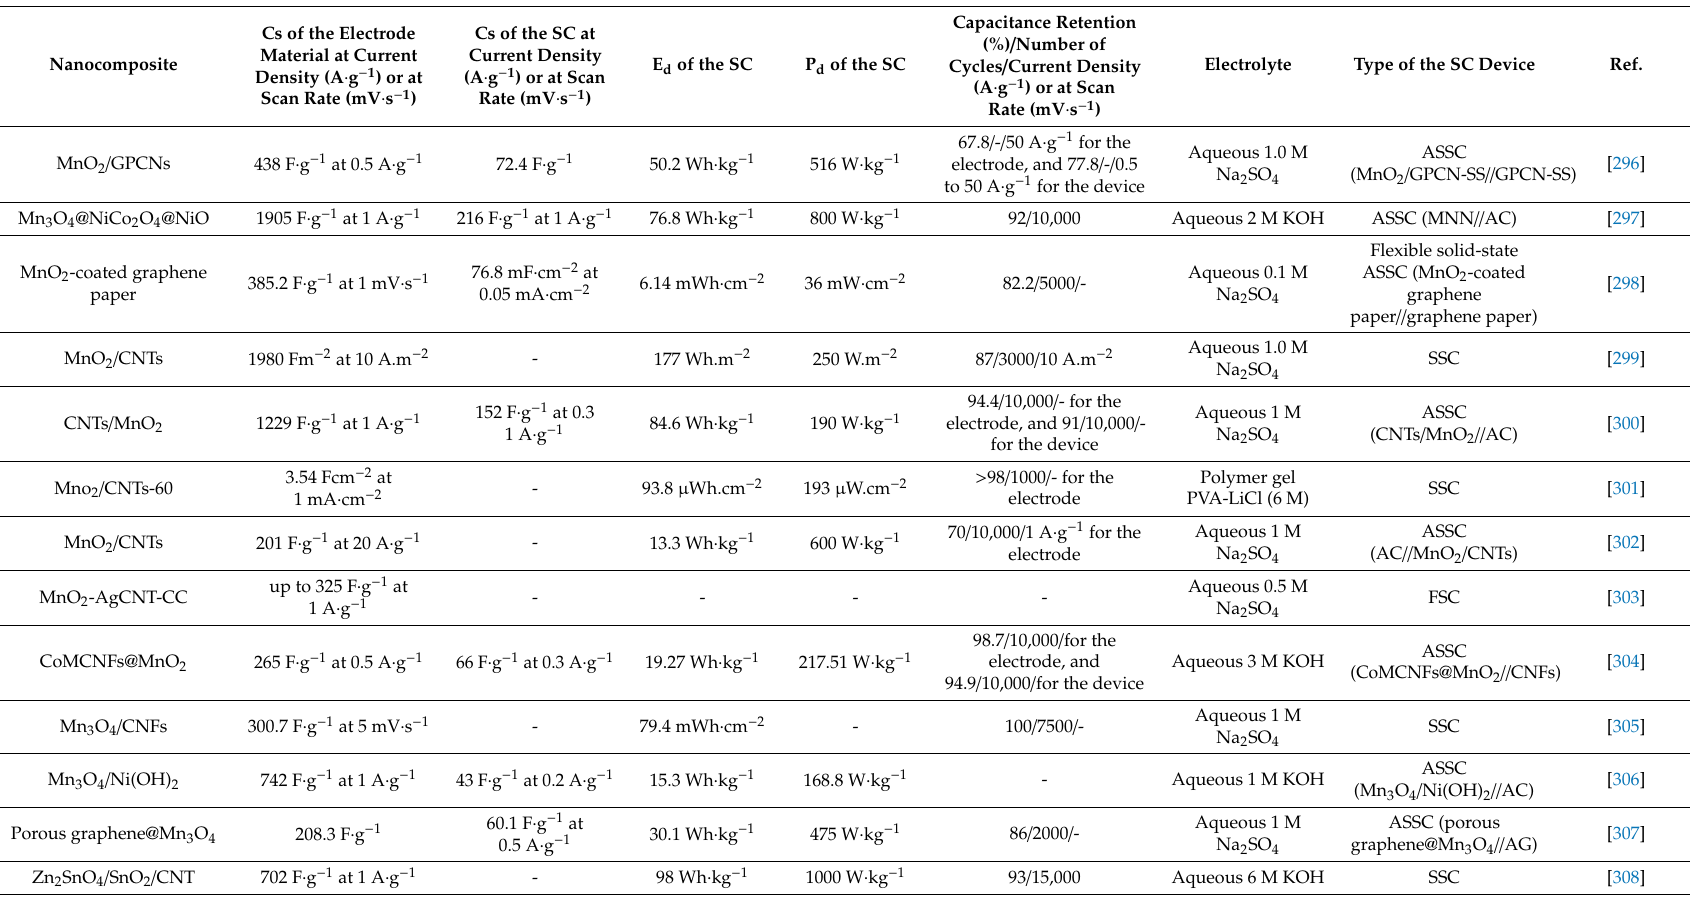
Table 1. A comparison of the recent metal oxide-based electrode materials performance utilized in various types of SC devices. (Cs: specific capacitance).